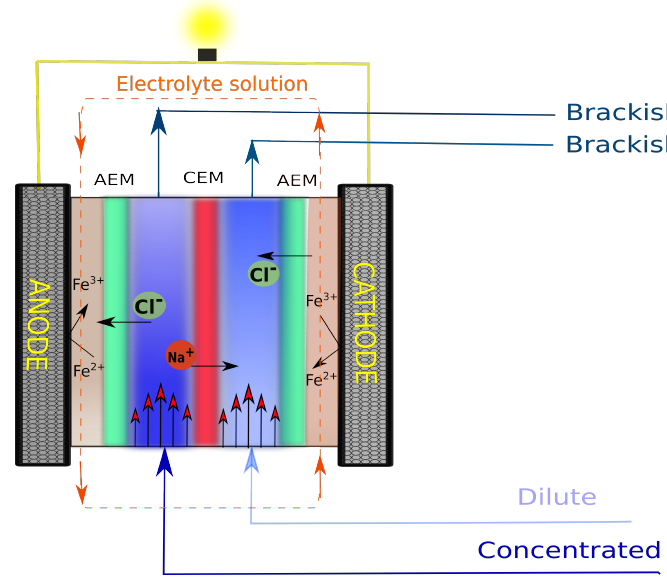
Figure 1. Schematic of a simple RED stack, containing (from the left) an anode, an anode electrolyte compartment, a unit cell, an additional membrane, a cathode electrolyte compartment, and a